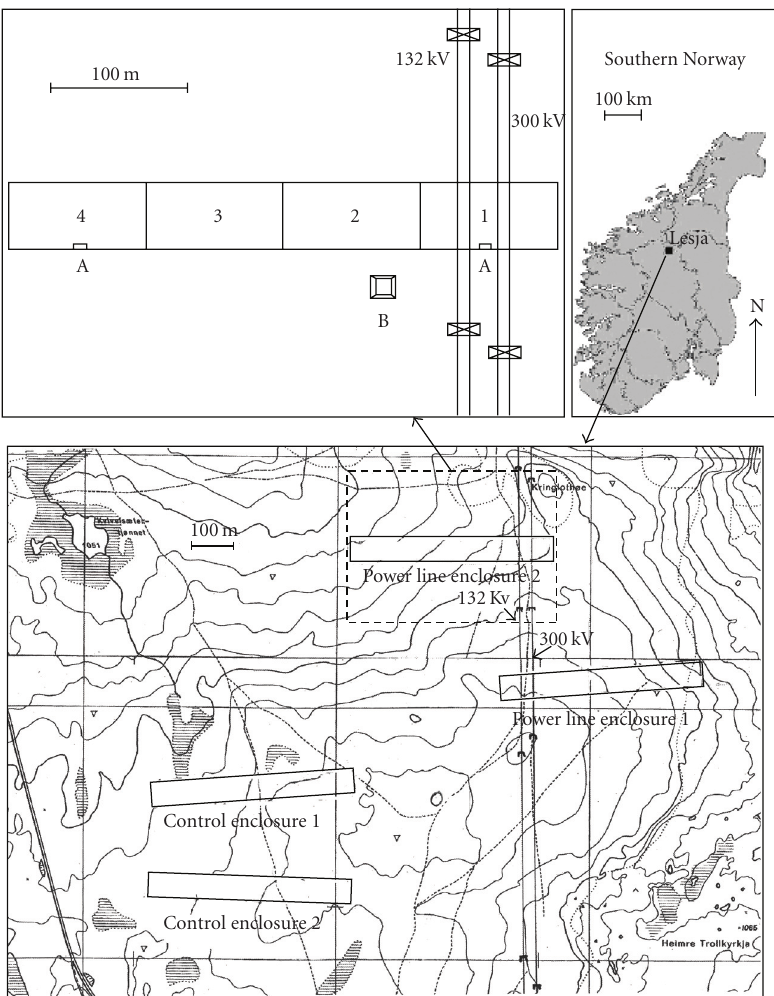
Figure 1: Location of the study area in Southern Norway and the location of the power lines and the four enclosures. The illustration of one of the enclosures shows the four 100 m zones: (A) the placement of drinking stations, and (B) the observation